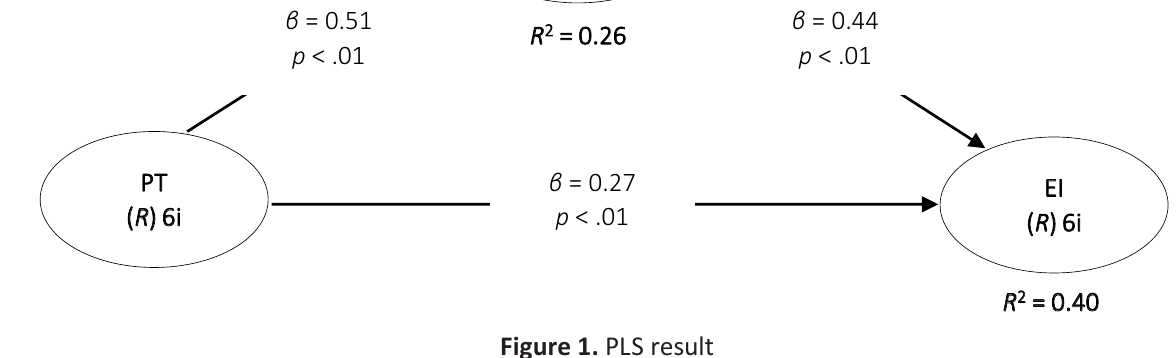
Figure 1. PLS result